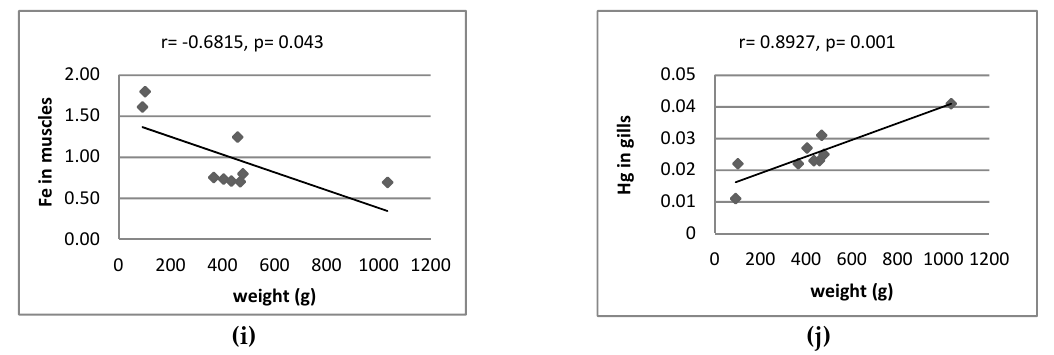
Figure 4. Correlation between contents of metal (mg/kg wet weight) and weight of fish. r— correlation coefficients; p —significant level; ( a ) pike, ( b ) pike, ( c ) pike, ( d ) bream, ( e ) bream, ( f ) perch, ( g ) perch, ( h ) perch, ( i ) roach, ( j ) roach.